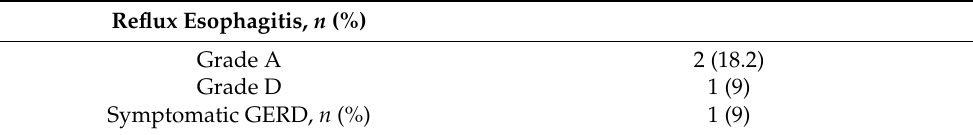
Table 4. GERD after